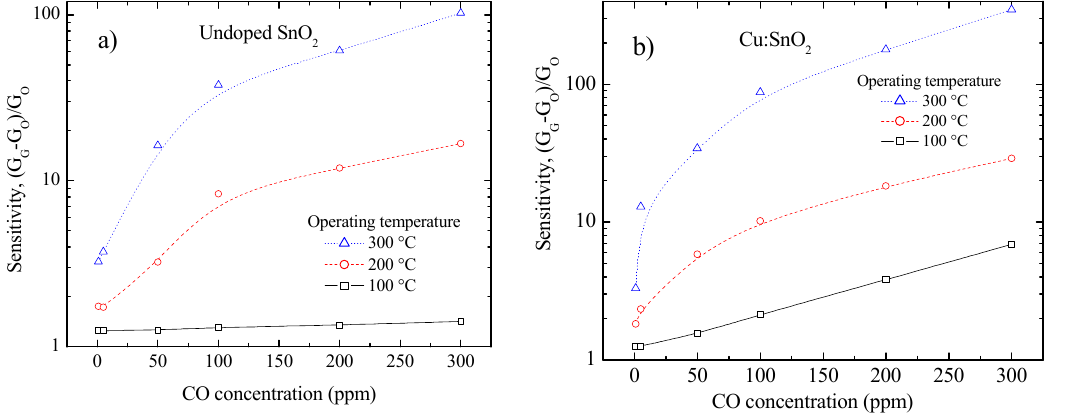
Figure 7. CO sensing response of ( a ) pure and ( b ) Cu-incorporated SnO 2 pellets.